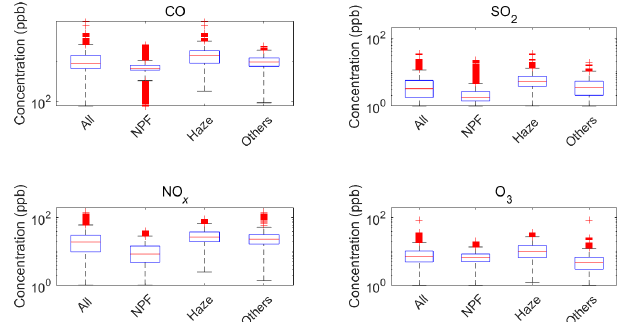
Figure 5. Trace-gas mixing ratios of CO, SO 2 , NO x and O 3 on all the days, NPF event days, haze days and other days. The boxes show the median (red line), 25th and 75th percentiles of the mixing ratios. Data marked with red plus symbols represent outliers as in Fig. 1.